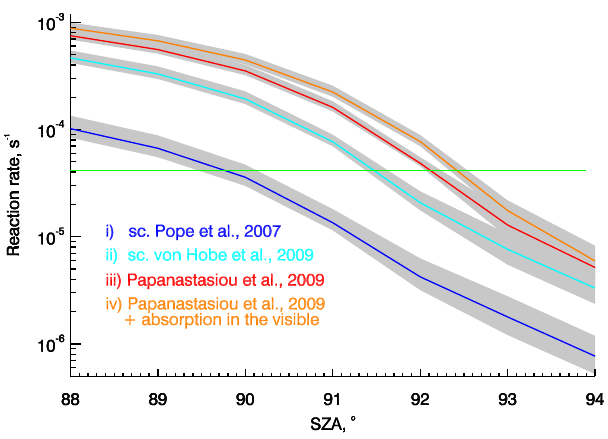
Fig. 5. Photolysis rate constants based on cross sections i–iv versus solar zenith angle. The green line shows the thermal dissociation rate k diss [M] for comparison. k diss was determined from the recom- bination constant taken from JPL 2011 and the thermal equilibrium constant from Plenge et al. (2005). The number density [M] was calculated for the mean temperatures and pressure on the track of the Geophysica during the self-match flight. The grey areas show uncertainties in J ClOOCl resulting from uncertainties in the actinic flux.